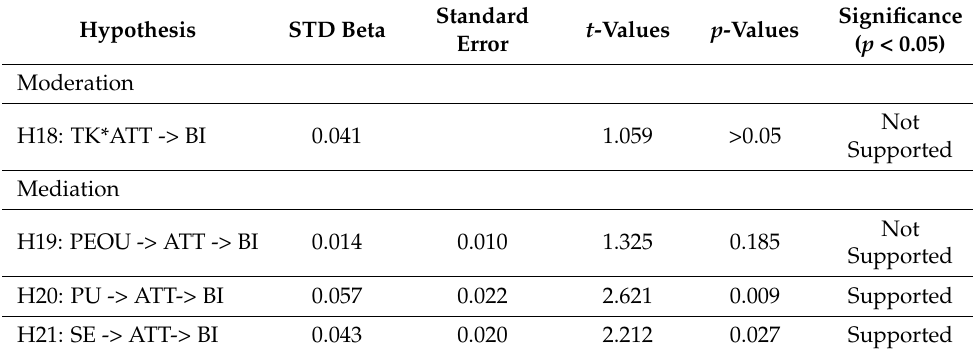
Table 6. Testing results of moderation and mediation.